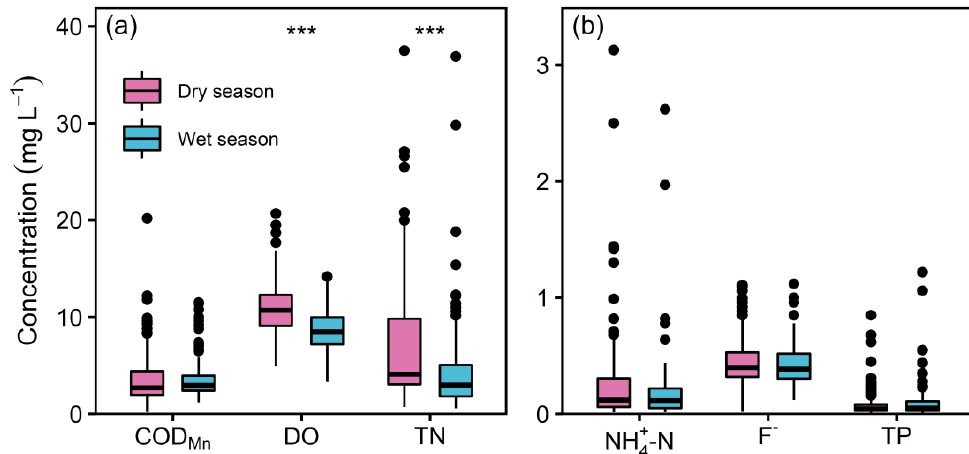
Figure 2. Water quality indicators during the dry and wet seasons. ( a , b ) The horizontal lines in the boxes indicate the median values, while the upper and lower border lines of the boxes indicate the upper quartile and lower quartile, respectively. *** indicates the statistical significance between the two seasons at p < 0.001. Abbreviations: COD Mn , chemical oxygen demand; DO, dissolved oxygen; -N, ammonia nitrogen; F − , fluoride; TP, total phosphorus. TN, total nitrogen; NH + 4